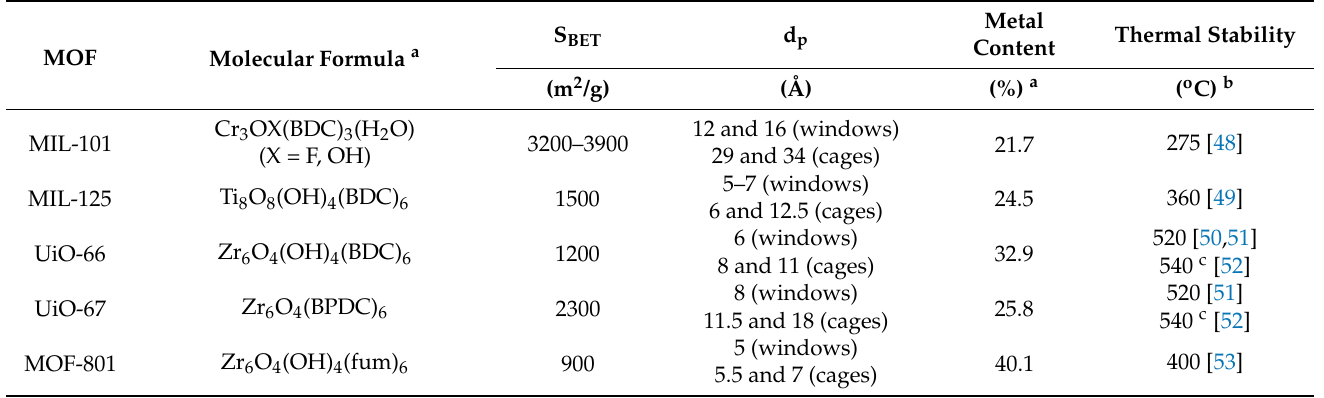
Figure 1. Representative structures of metal–organic frameworks (MOFs) with high thermal and chemical stability. Table 1. Physicochemical characteristics of some MOFs with high chemical and thermal stability.